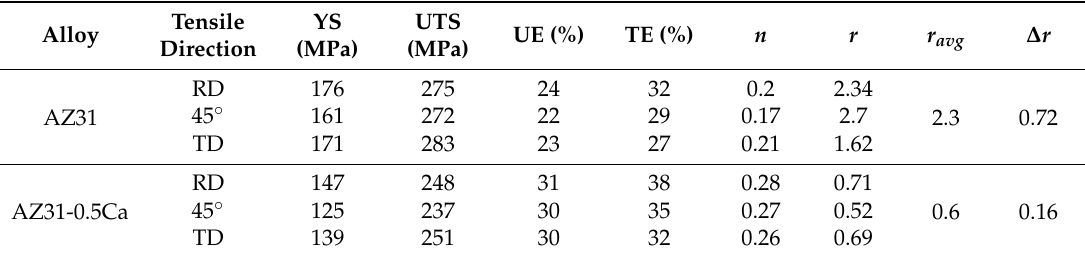
Figure 4. ( a , b ) SEM micrographs of the AZ31-0.5Ca alloy showing fine (Mg,Al) 2 Ca particles and the related energy-dispersive X-ray spectroscopy taken on the particles [7]; ( c ) X-ray diffraction pattern of AZ31 and AZ31-0.5Ca; ( d ) (Mg,Al) 2 Ca particle size distributions in AZ31-0.5Ca. Table 3. Room-temperature tensile properties and mechanical anisotropy parameters of AZ31 and AZ31-0.5Ca alloys. Strain hardening exponents presented in Table 3 were calculated by using true stress-true strain curves of the alloys (not shown